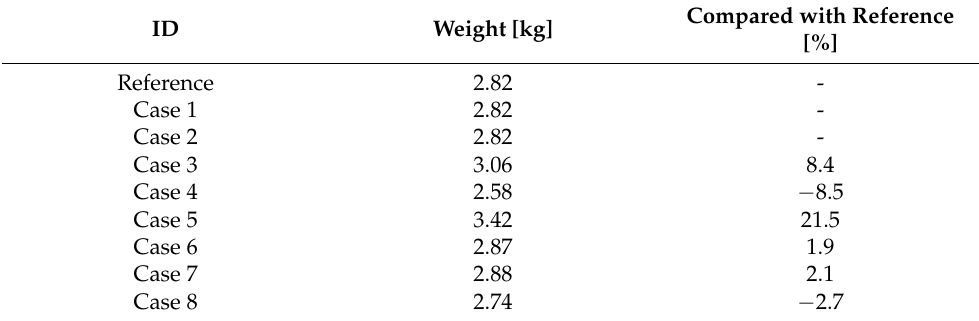
Table 6. Weight by